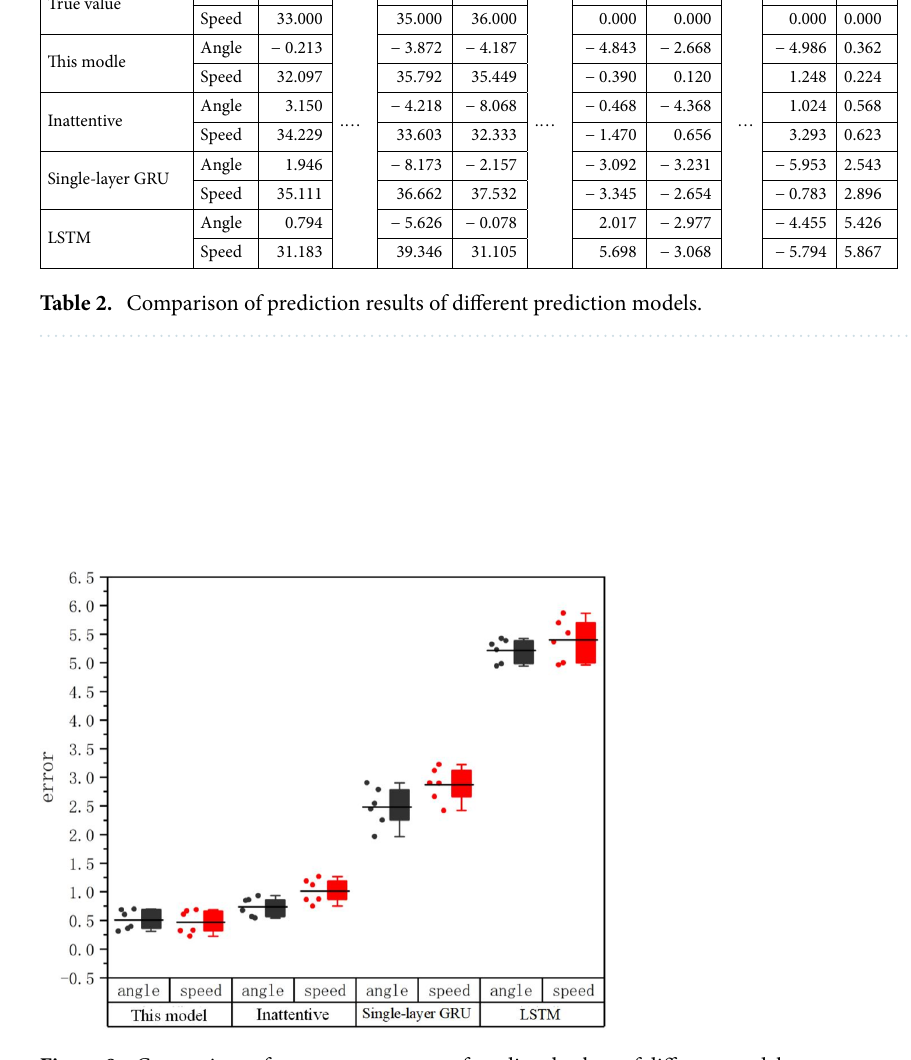
Figure 8. Comparison of mean square errors of predicted values of different